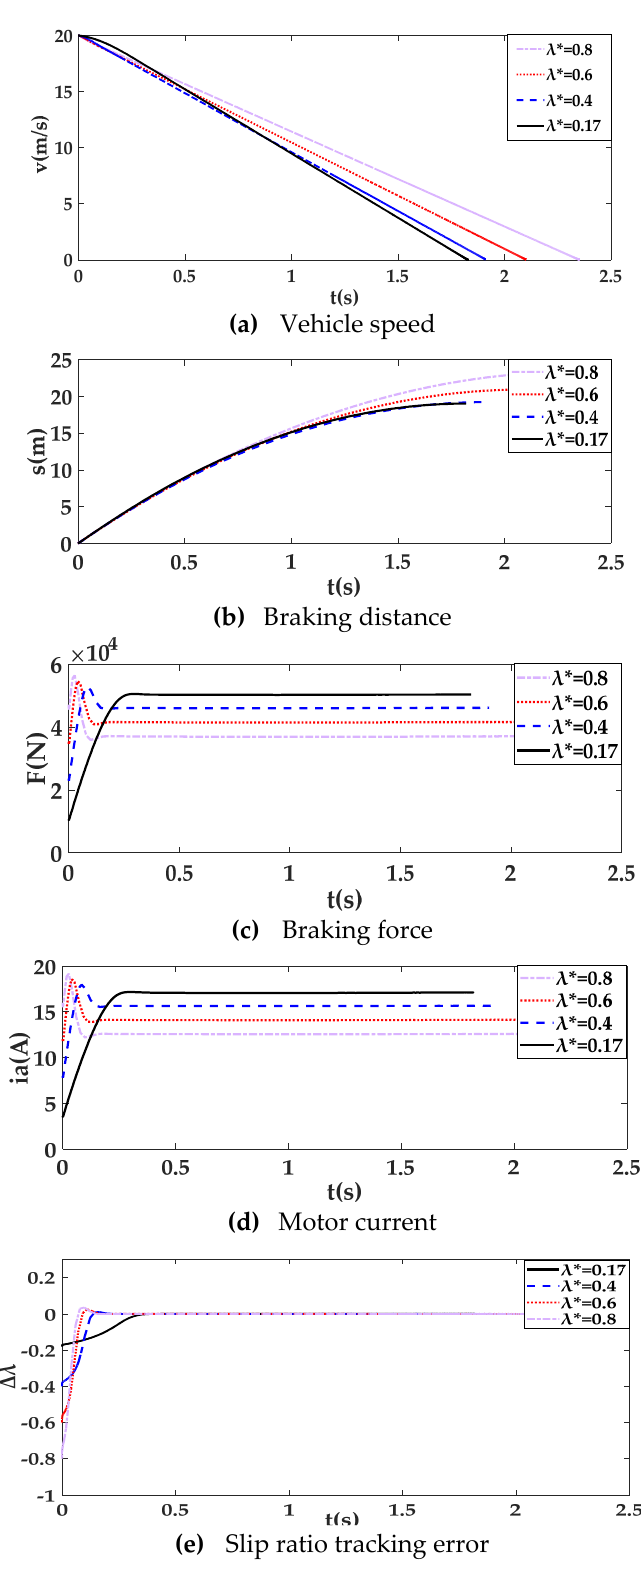
Figure 7. Dry asphalt road surface simulation.